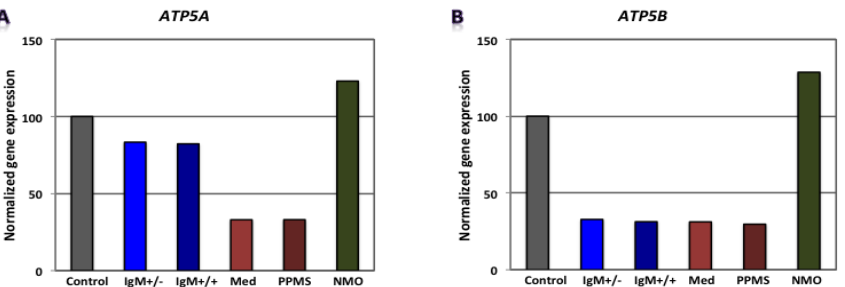
Figure 4. Normalized gene expression involved in oxidative phosphorylation in CGNs treated with CSF of MS and NMO patients. ( A ) ATP synthase subunit 5A, ATP5A; ( B ) ATP synthase subunit 5B, ATP5B. CGNs: cerebellar granule neurons; RMS (G+/M− and G+/M+): types of inflammatory MS; SMS: Spinal MS (Med); PP: Primary progressive multiple sclerosis; NMO: Neuromyelitis Optica.